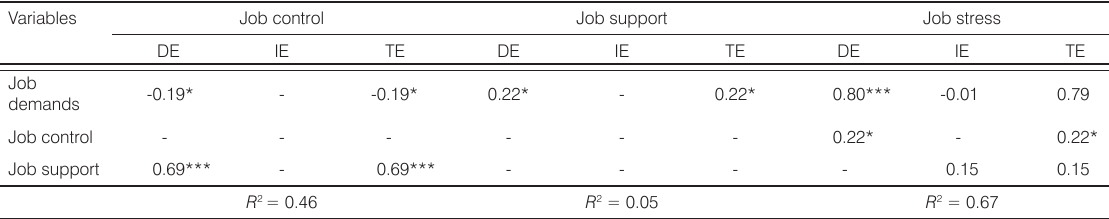
Table 4. Parameter estimates of DE, IE, and TE of the modified model ( n = 272) . ( β = -0.04, P =0.795), the path was deleted from